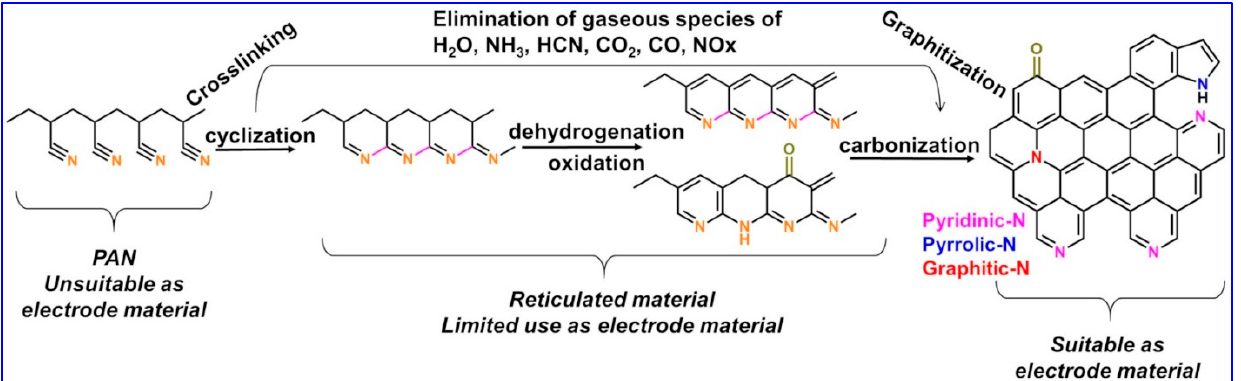
Figure 3. SEM images of Au@PAN fibers (insets are the tissues collected after electrospinning, yellowish for the presence of gold (III) salt) obtained with: ( A ) regular secondary electrons detector and ( B ) back-scattered electrons detector [34]. Reprinted and adapted with permission from ref. [34]; Copyright 2016, Wiley-VCH Verlag GmbH and Co. KGaA, Weinheim.